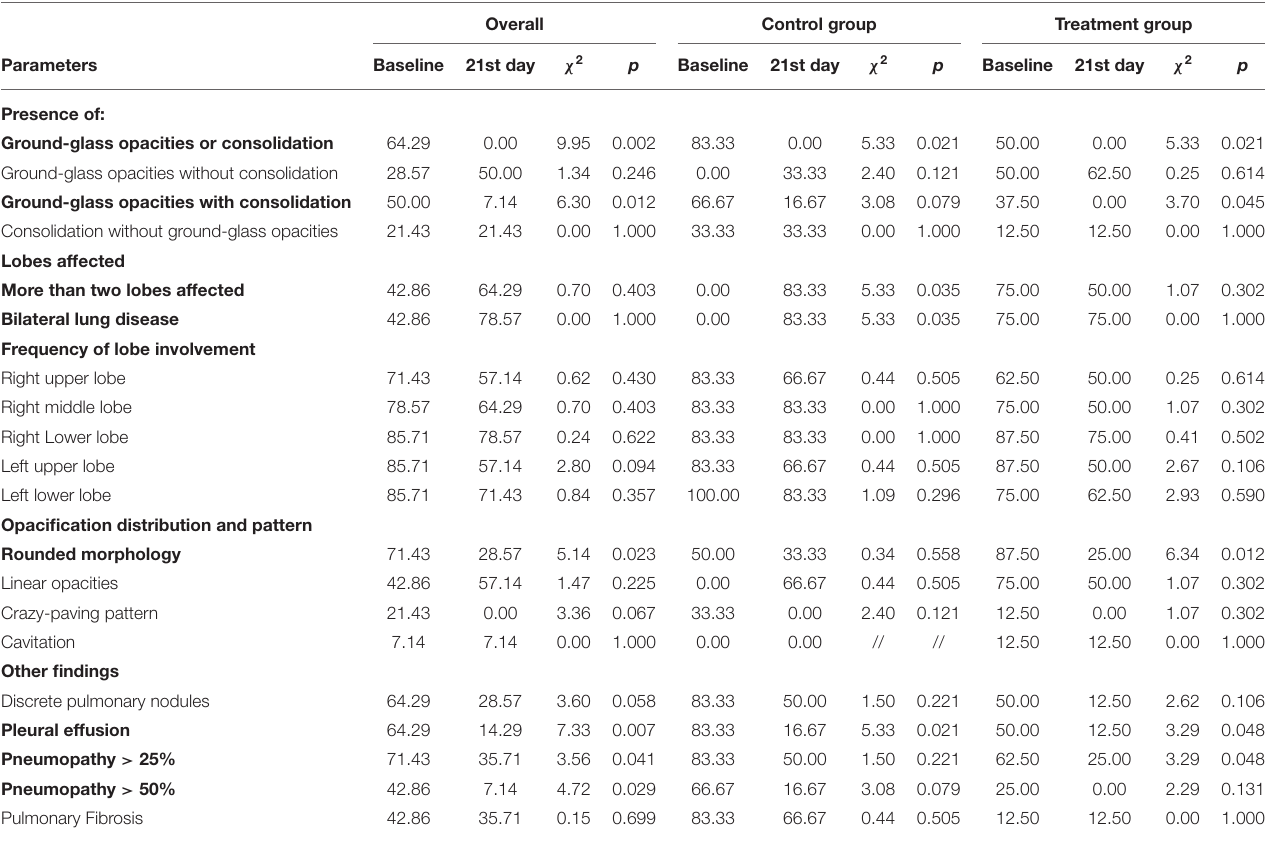
TABLE 4 | Table contingency of qualitative change after 21 days in finding CT. Overall Control group Treatment